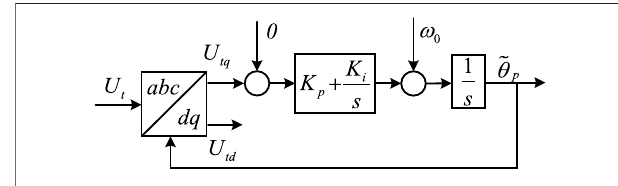
FIGURE 5 | Control structure of the PLL